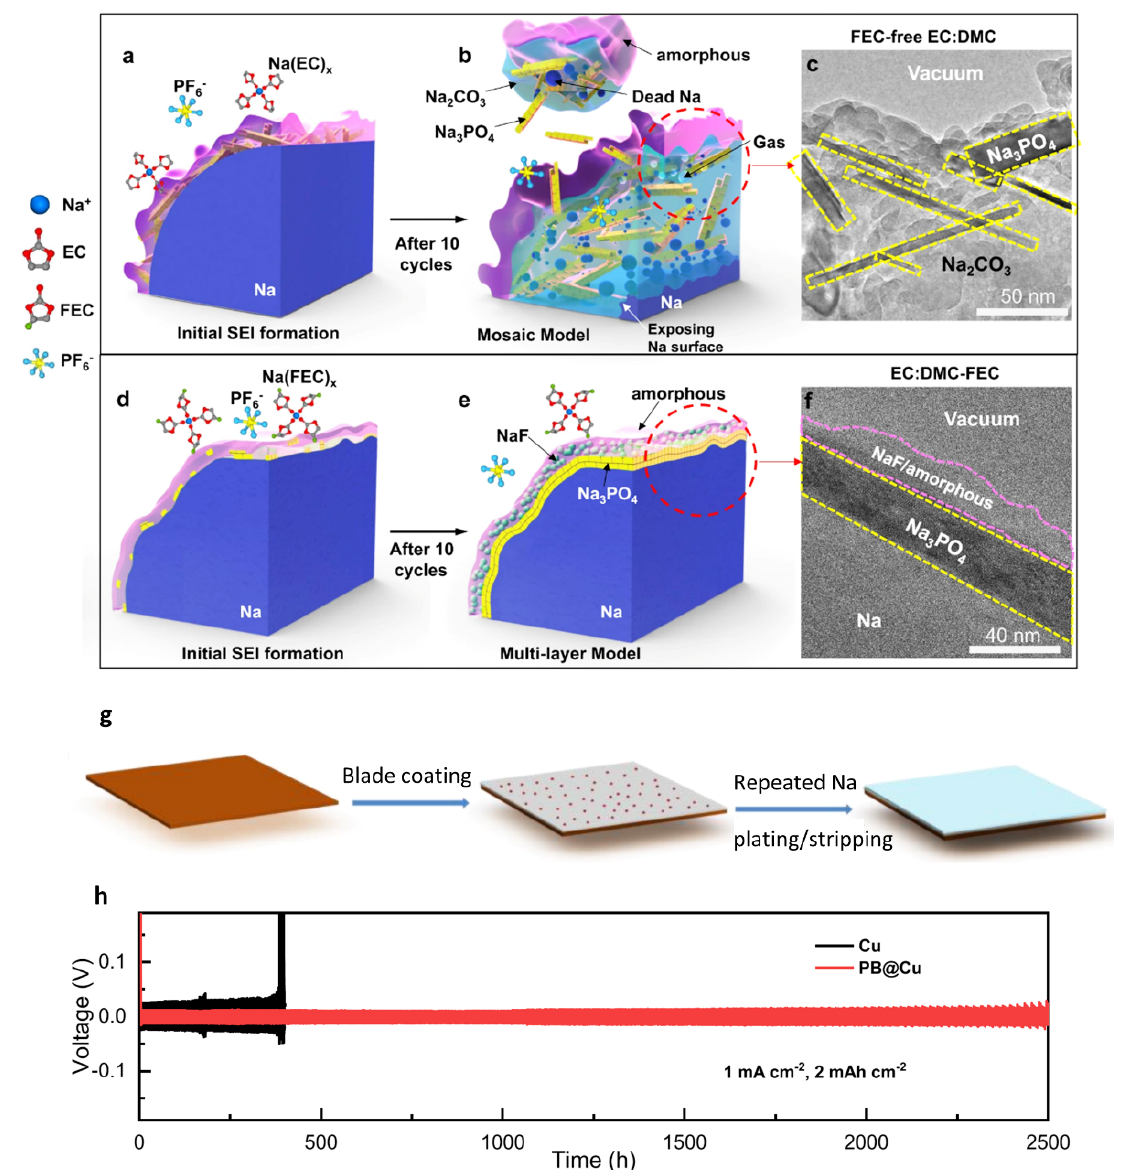
Figure 4. Initial SEI formation and the models after 10 cycles in the electrolyte of ( a – c ) NaPF 6 FEC–free EC: DMC–based electrolyte, ( d – f ) NaPF 6 EC: DMC–based electrolyte with FEC additive [44]; with permission from Springer Nature, copyright 2021. ( g ) PVdF and Bi powder (named PB@Cu)–coated Cu foil and the repeated Na plating/stripping processes; ( h ) the following Na plating/stripping test at a current density of 1 mA cm − 2 and area capacity of 2 mAh cm − 2 [47]. Reproduced with